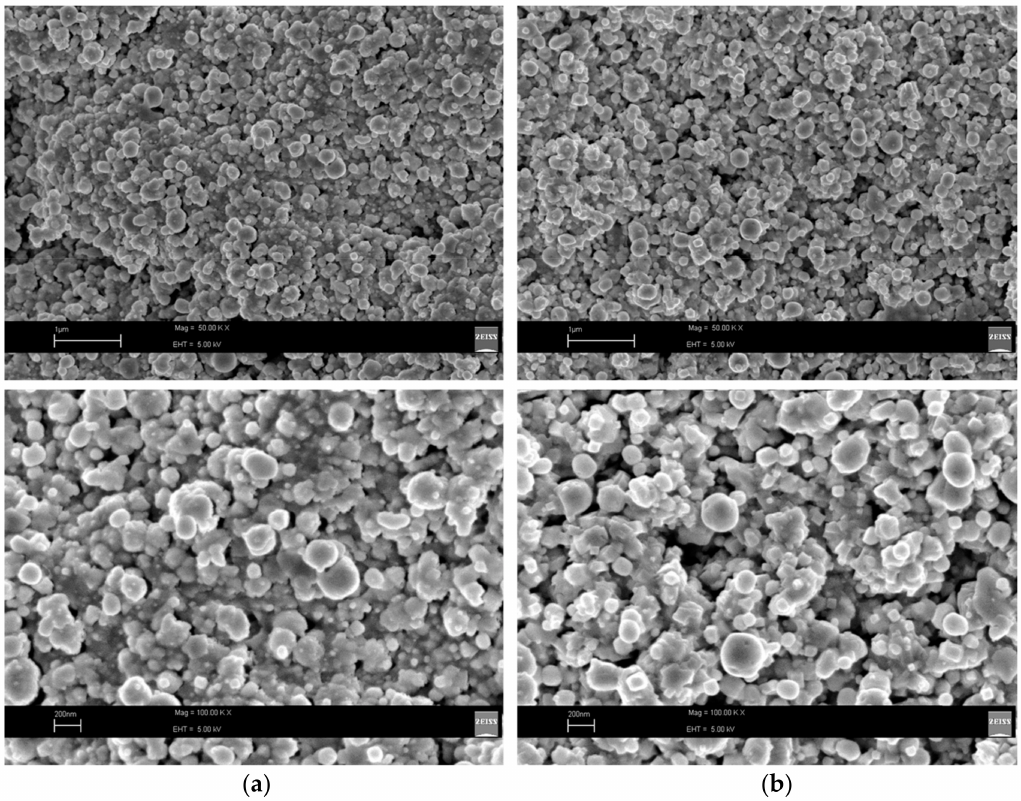
Figure 3. FE-SEM secondary electrons images of thin films: ( a ) PbTe05 and ( b ) PbTe20 at different magnifications. The nanostructured morphology of PbTe grains (~30 to 220 nm) is